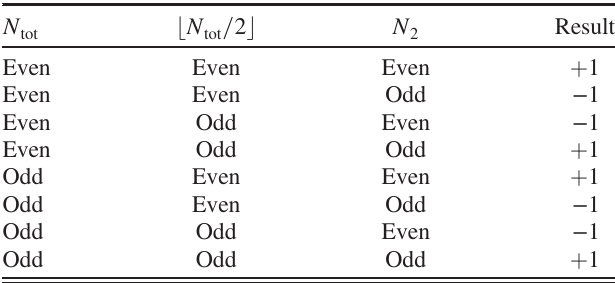
TABLE I. Characterization of measurement outcomes for V